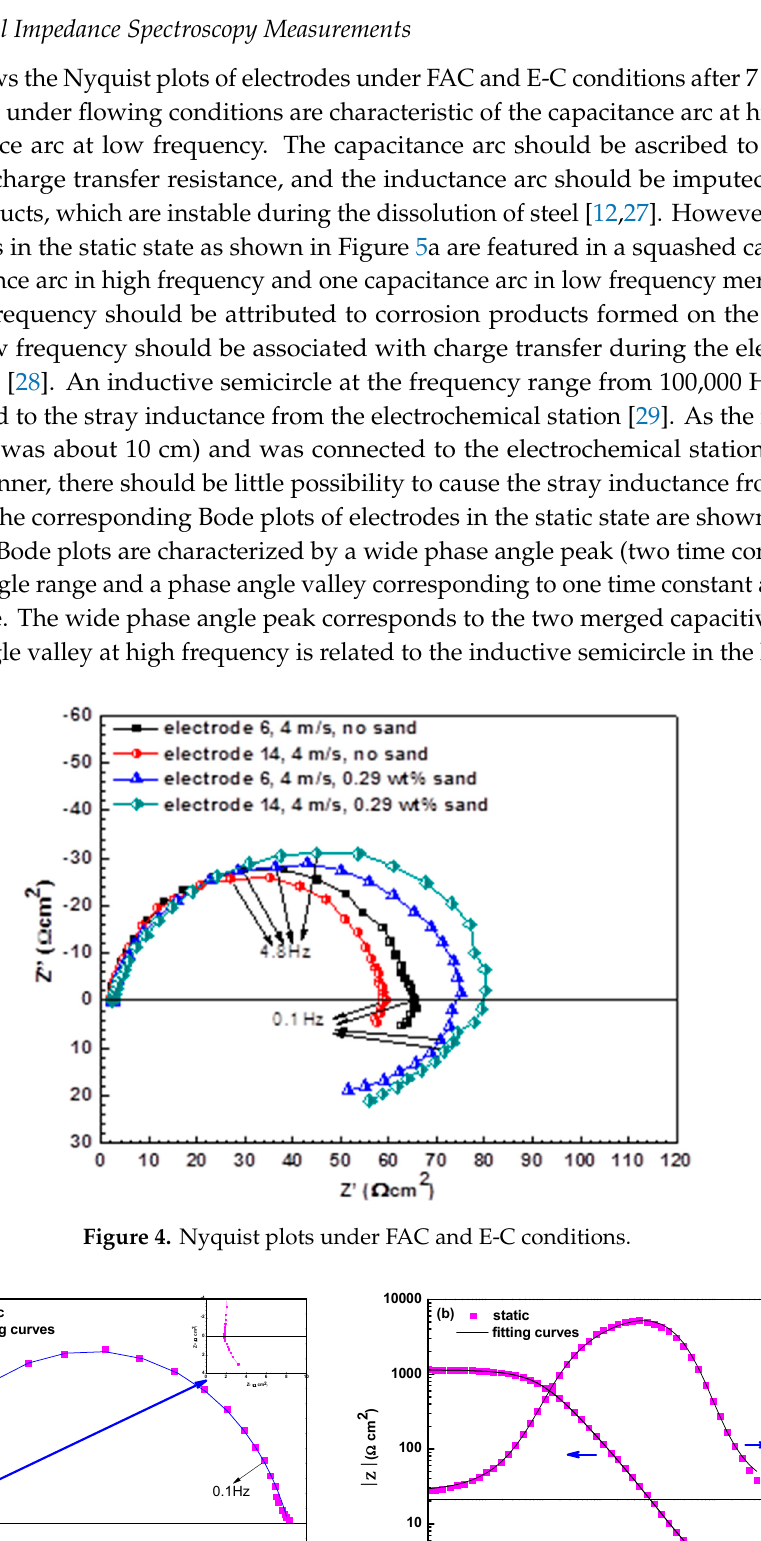
Figure 3. ( a ) Distribution of corrosion rate after the flow-accelerated corrosion (FAC) test and ( b ) contours of corrosion rate after FAC test.